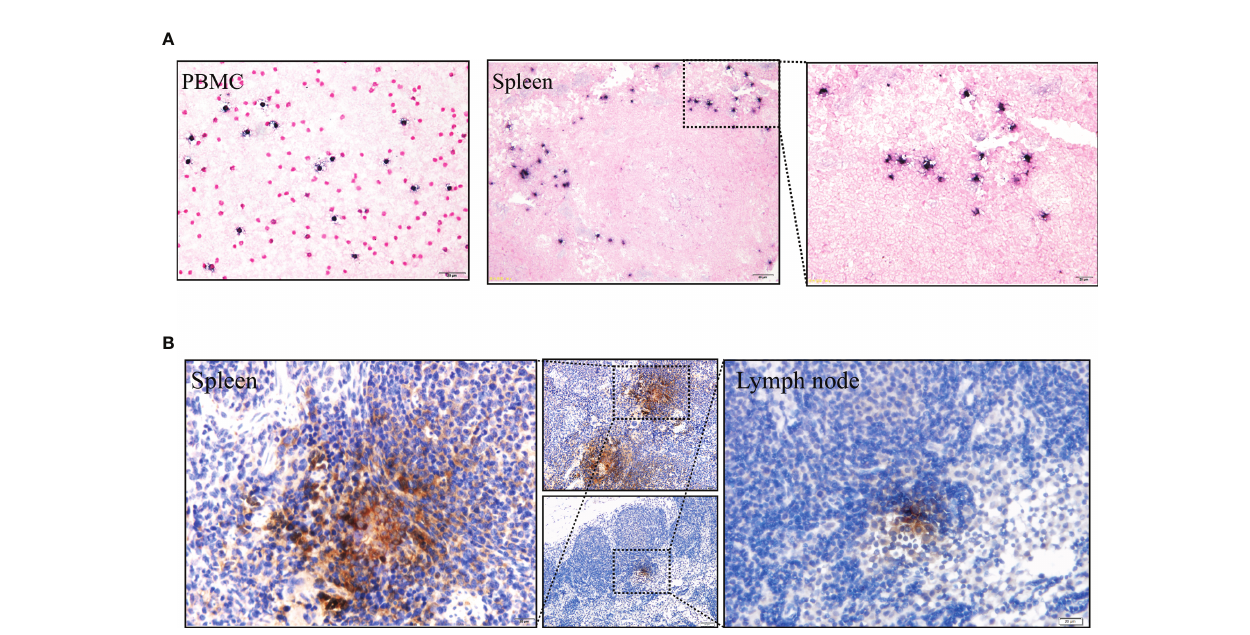
FIGURE 5 | (A) EBERs expression of PBMCs and spleen, detected by in situ hybridization at 91 dpi. Positive staining is gray/black, nuclei counterstained with neutral red. (B) Immunohistochemical detection of LMP1 protein of the spleen and lymph node at 91 dpi. Positive viral proteins and negative cells are shown in brown and blue,